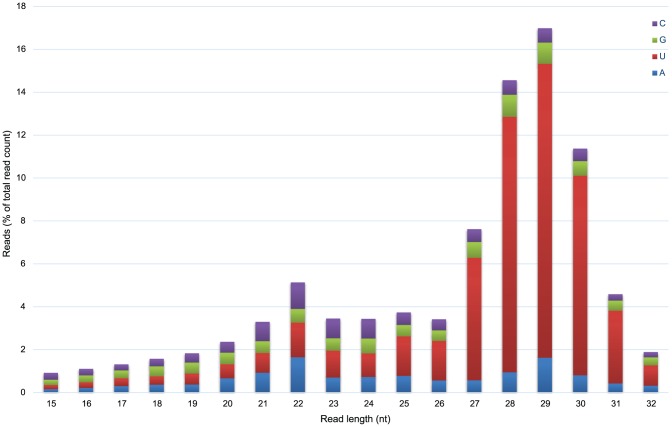
Frequency distribution of small RNA reads in the S. pistillata sequencing library.The bars are coloured to reflect the proportions of reads starting with A, U, G, and C (blue, red, green, and purple respectively).